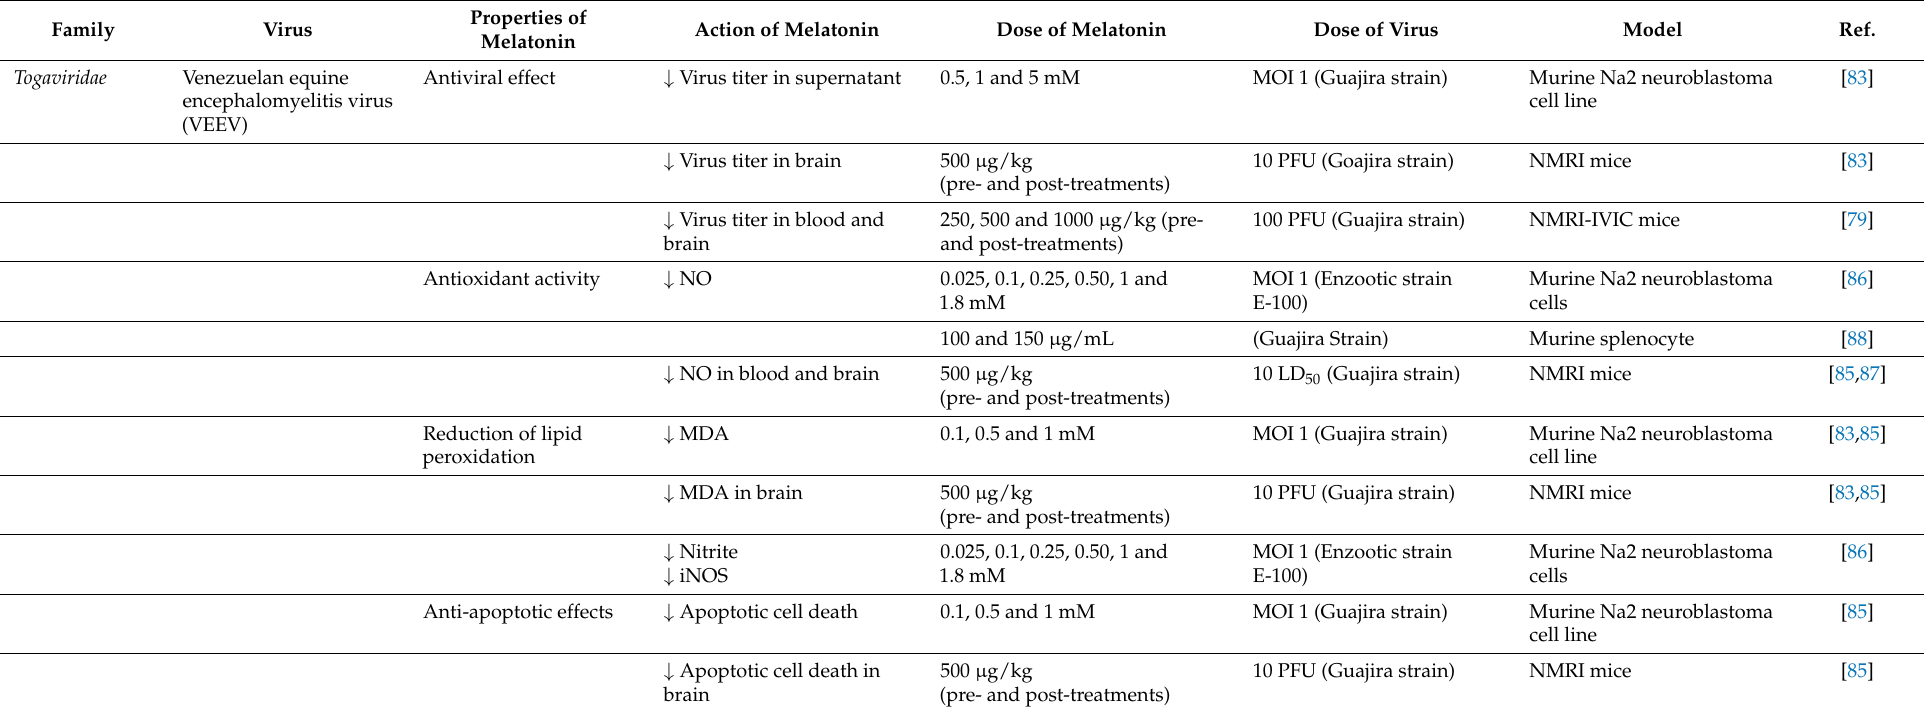
Table 1. The Summary Effects of Melatonin against Virus Infection both in vitro and in